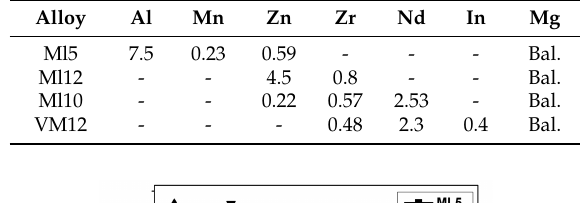
Table 2. Concerning the temperature range 20 to 293 K, the alloy VM12 shows the best combination of mechanical properties. Magnesium alloy MI10 also shows satisfactory properties, see Figure 3. Table 2. Composition of magnesium alloys investigated in [17]. Table 2. Composition of magnesium alloys investigated in [17].